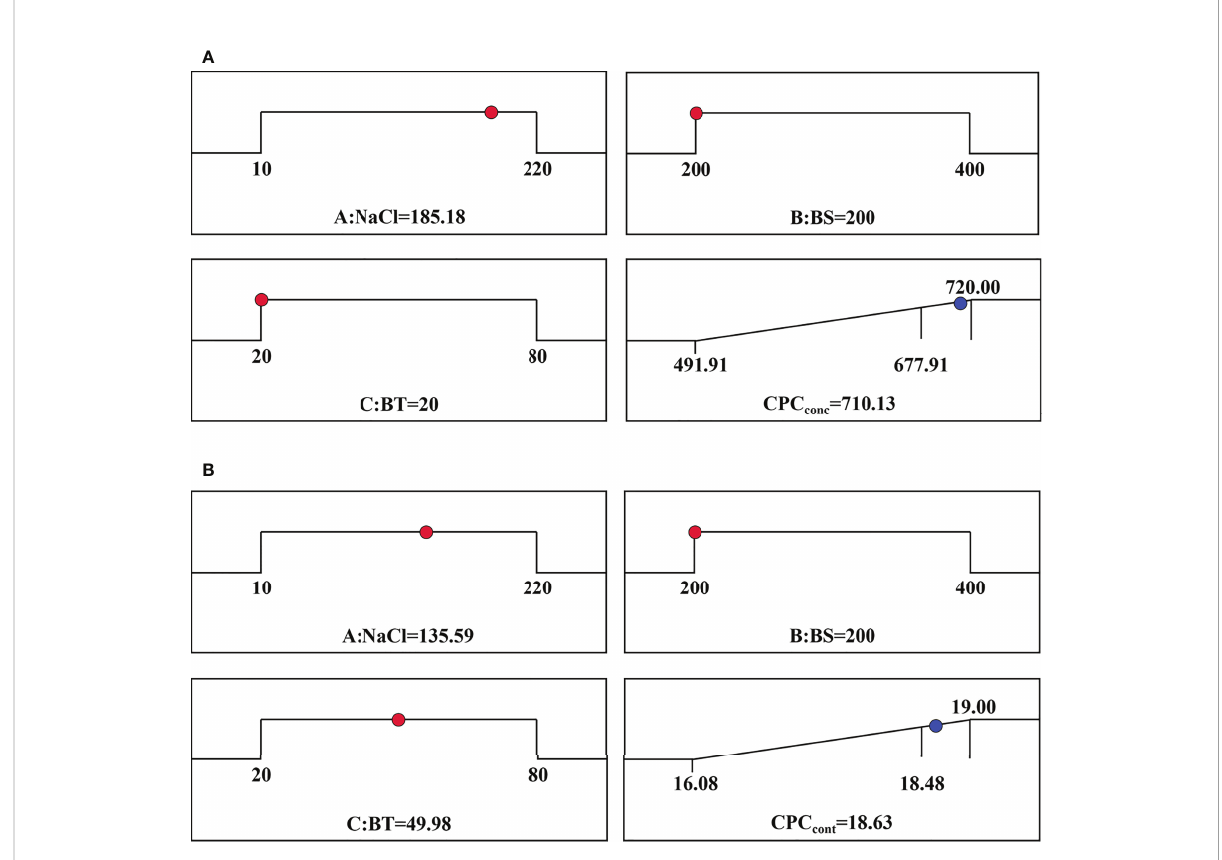
FIGURE 4 Optimal conditions predicted by the models for (A) CPC conc and (B) CPC cont